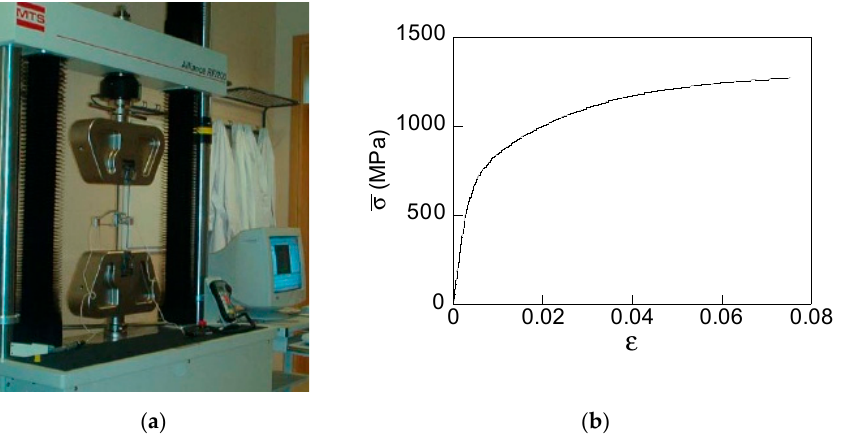
Figure 2. Conventional tension test: ( a ) experimental set-up and ( b ) experimental stress–strain curve of the raw material before cold drawing.